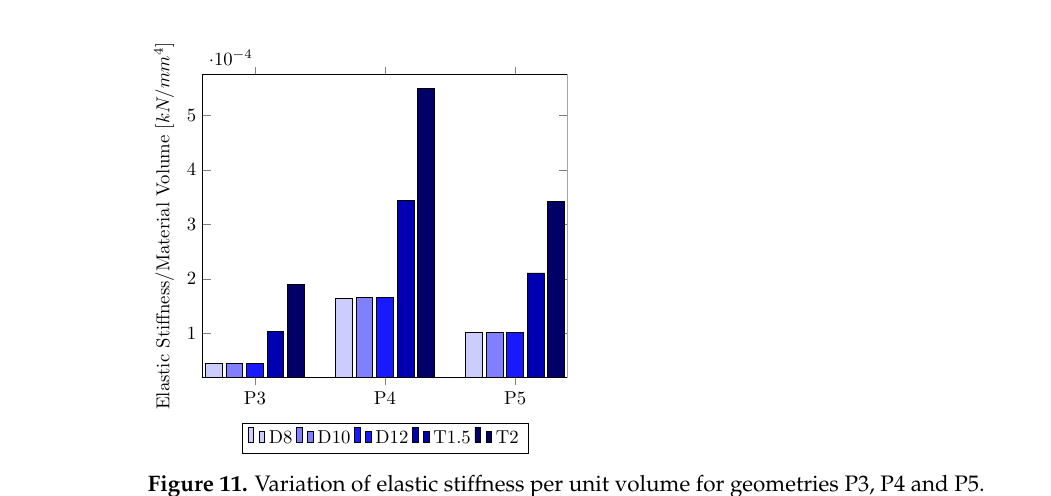
Figure 11. Variation of elastic stiffness per unit volume for geometries P3, P4 and P5.